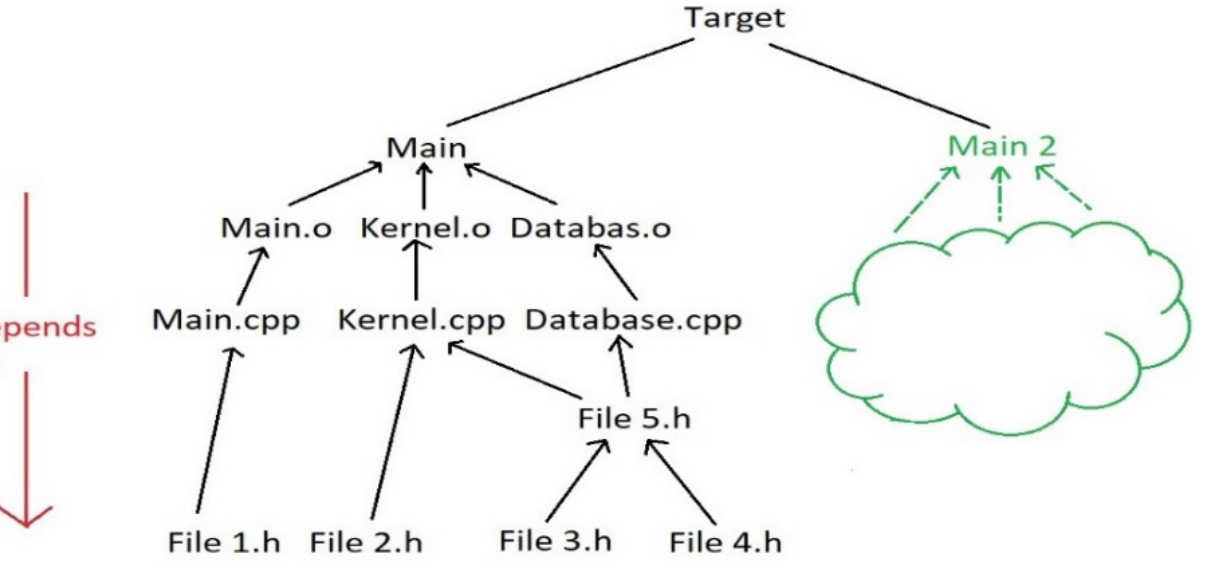
Figure 1. Dependencies file structure [3].